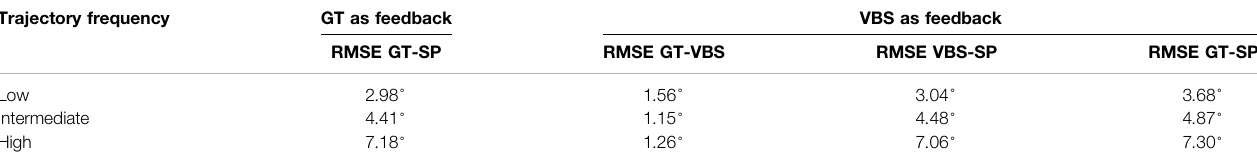
TABLE 1 | Overview of the different root-mean-square errors (averaged between the two angles) when using ground truth (GT) as feedback (column two) or when using the vision-based sensing approach (VBS) as feedback (columns three to fi ve). The evaluation is done for trajectories of different frequencies shown in rows three to fi ve. The setpoint is abbreviated with SP. The signals used to calculate the root-mean-square errors (RMSE) are indicated by the two abbreviations following the RMSE. Trajectory